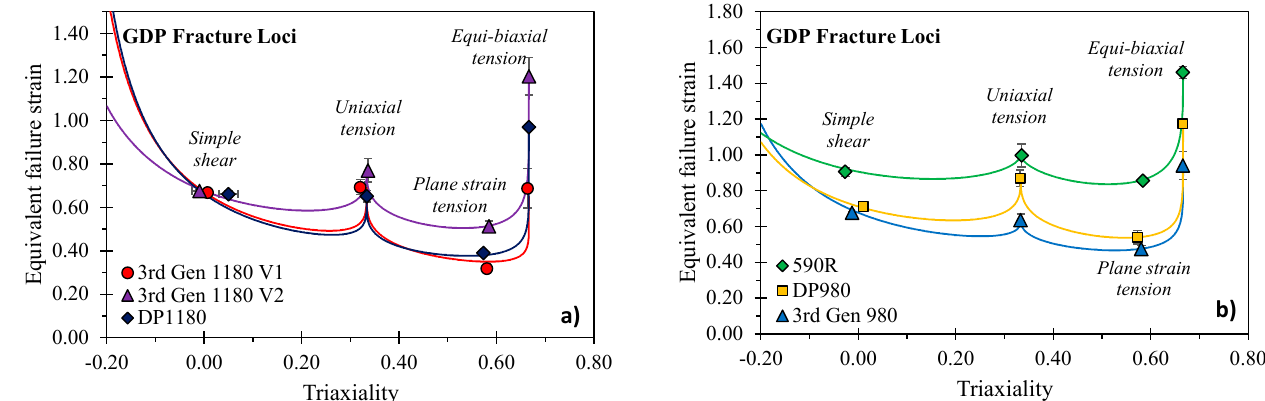
Figure 32. Calibrated fracture loci using the Generalized Drucker–Prager fracture model of Rahmaan et al. [66] for the 1180